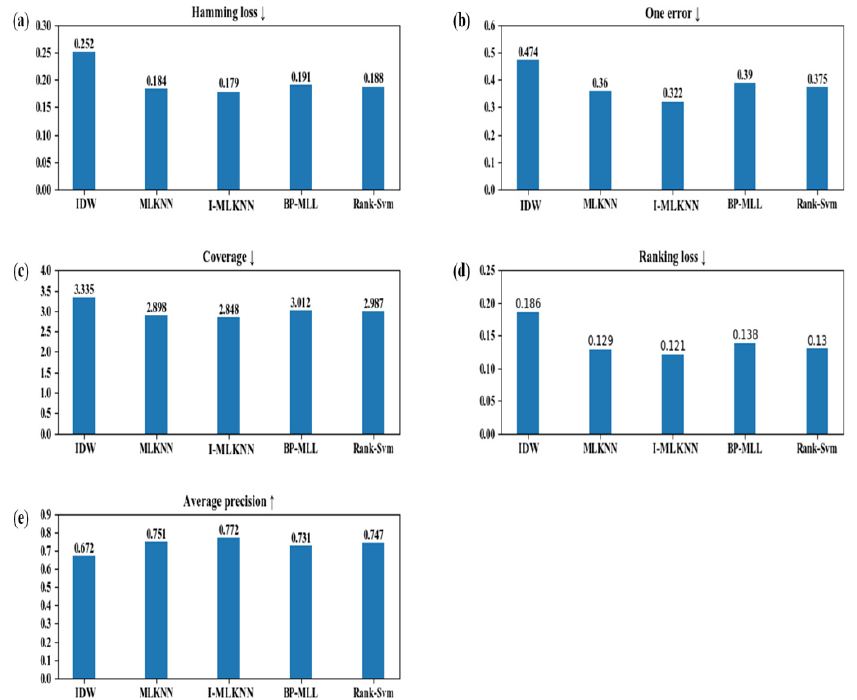
Figure 6. Comparison of different algorithm evaluation results. ( a ) Hamming loss; ( b ) One-error; ( c ) Coverage; ( d ) Ranking loss; ( e ) Average precision.